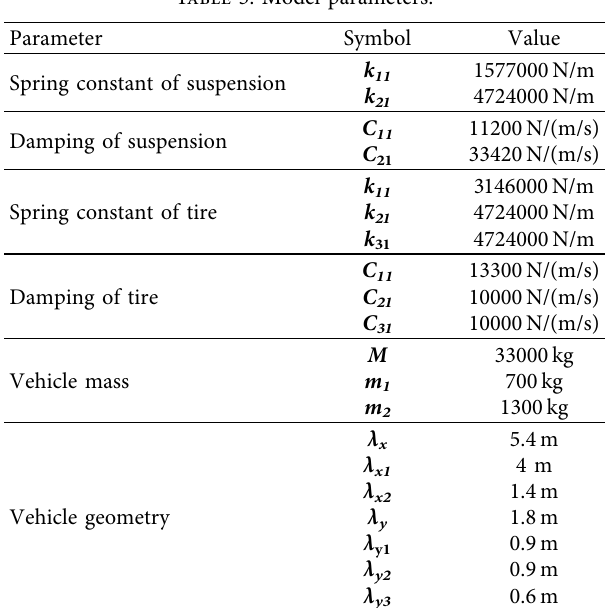
Table 5: Model parameters.